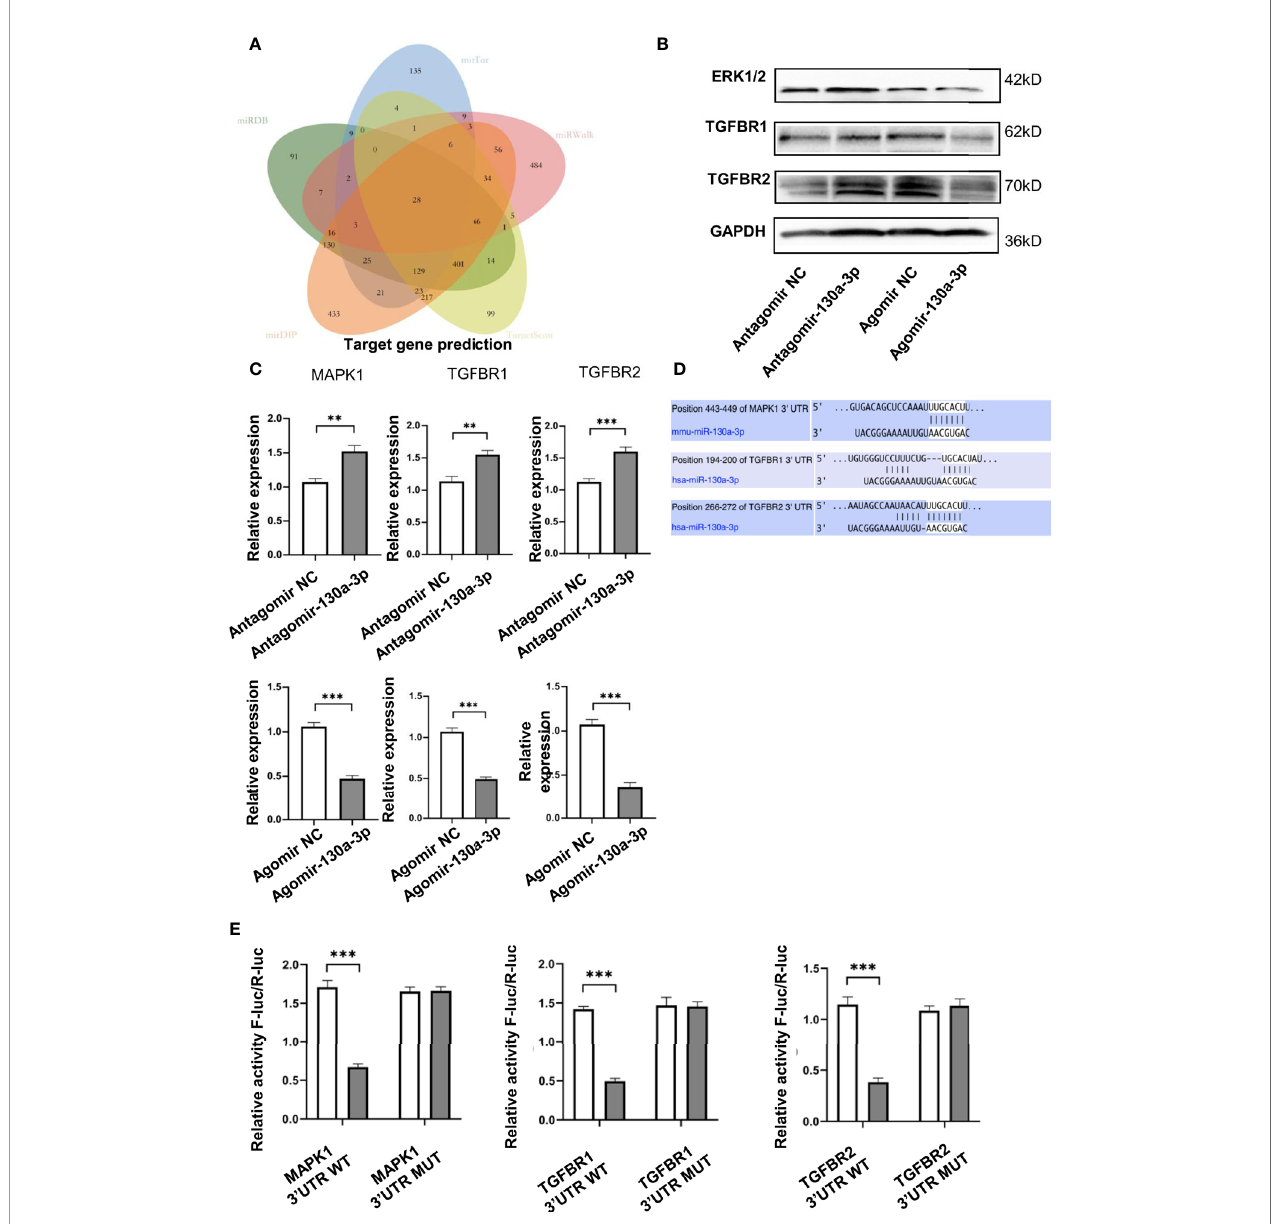
FIGURE 7 | miR-130a-3p target genes prediction. Venn diagram showing the overlap of the miR-130a-3p regulated target genes in the following fi ve algorithms: TargetScan, mirDIP, miRDB, mirTar, and mirDIP (A) . JS1 cells were transfected with the Agomir-130a-3p/Agomir NC, Antagomir-130a-3p/Antagomir NC for 72 h; the protein and mRNA expression of ERK1/2, TGFBR1, and TGFBR2 were detected by WB and qRT-PCR, respectively (B, C) . The binding sites of miR-130a-3p in 3 ′ UTR of MAPK1, TGFBR1, and TGFBR2 were predicted (D) . The wild-type and mutants 3 ’ UTR of MAPK1, TGFBR1, and TGFBR2 were cloned into pmirGLO, dual-luciferase reporter assay performed on 293 T cells transfected with MAPK1, TGFBR1, and TGFBR2 UTR reporter plasmid together with Agomir-130a-3p or Agomir N (E) . ** p <0.01 and *** p <0.001 (n=4 each